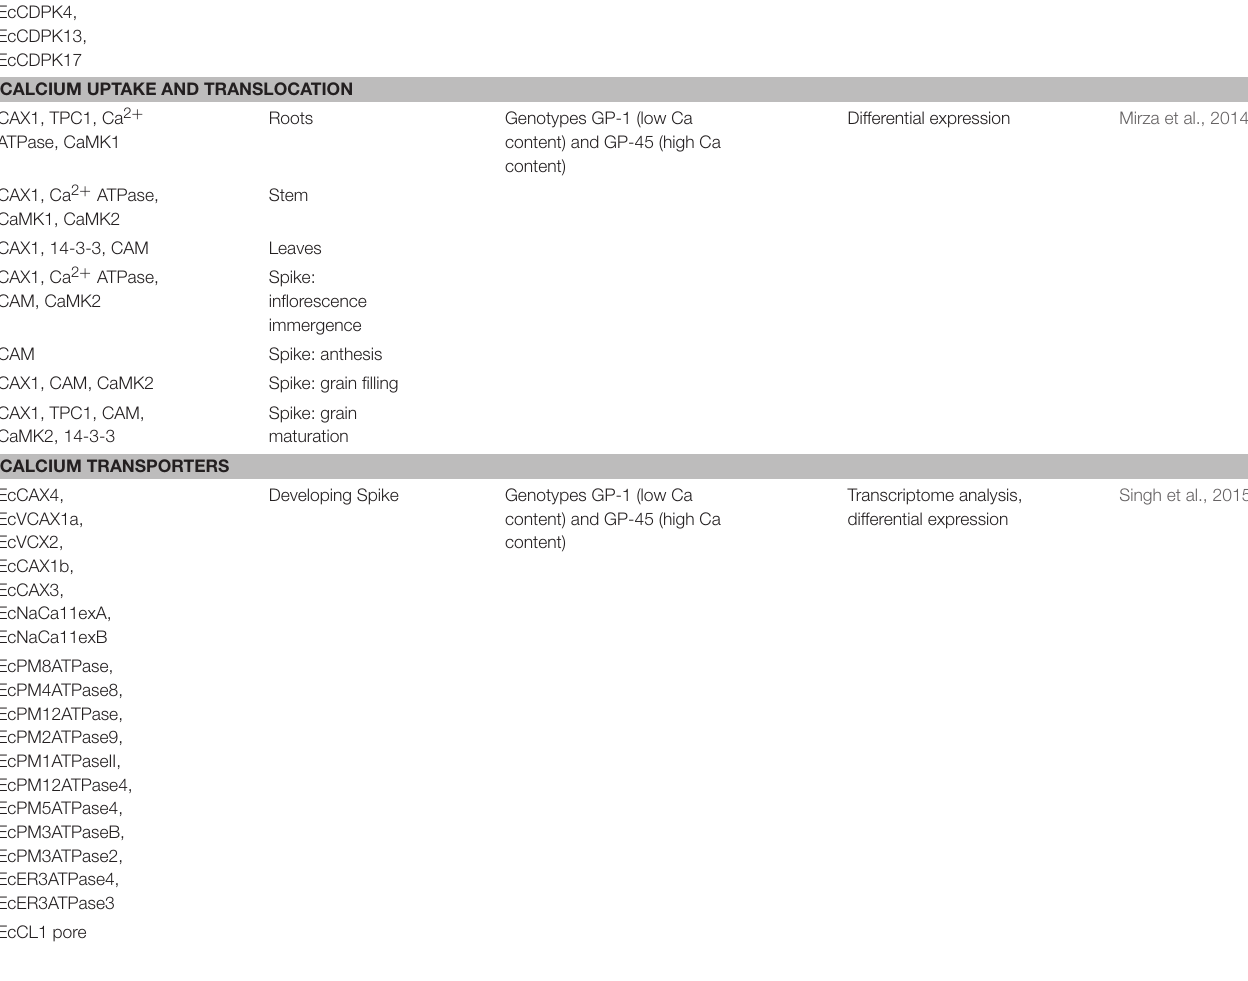
Frontiers in Plant Science |